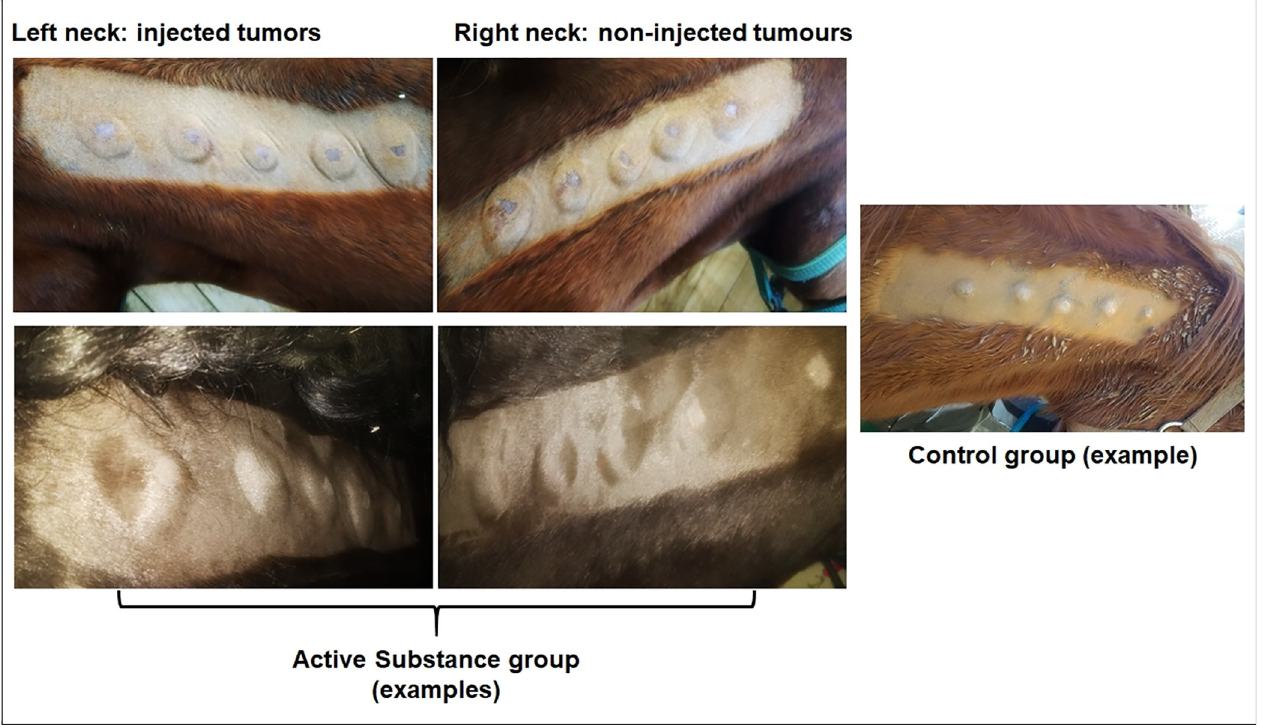
Fig 3. Injection of pseudo-sarcoids with iNSA/E6E7 equ and iNSB/E6E7 equ induced a systemic immune response. Injection of pseudo-sarcoids with iNSA/ E6E7 equ or iNSB/E6E7 equ (“active substance”) on the left side of the neck induced oedema at the injection sites, and importantly, also at the non-injected tumour sites on the right side of the neck. Intralesional administration of SNH-buffer at the left side of the neck of control horses had no apparent effect, except for short-lived oedema in one horse (not shown). Pseudo-sarcoids on the right side of the neck of control horses remained unchanged.